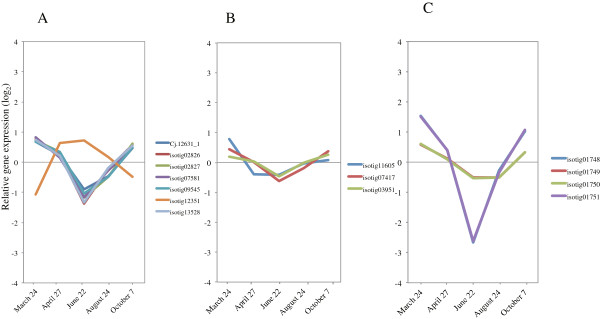
Expression of sucrose synthase, invertase, and sucrose phosphate synthase in cambial region during xylem formation. A) Sucrose synthase. B) Invertase. C) Sucrose phosphate synthase. The individual targets are summarized in Additional file 3. All expression data are presented on a log2 scale.